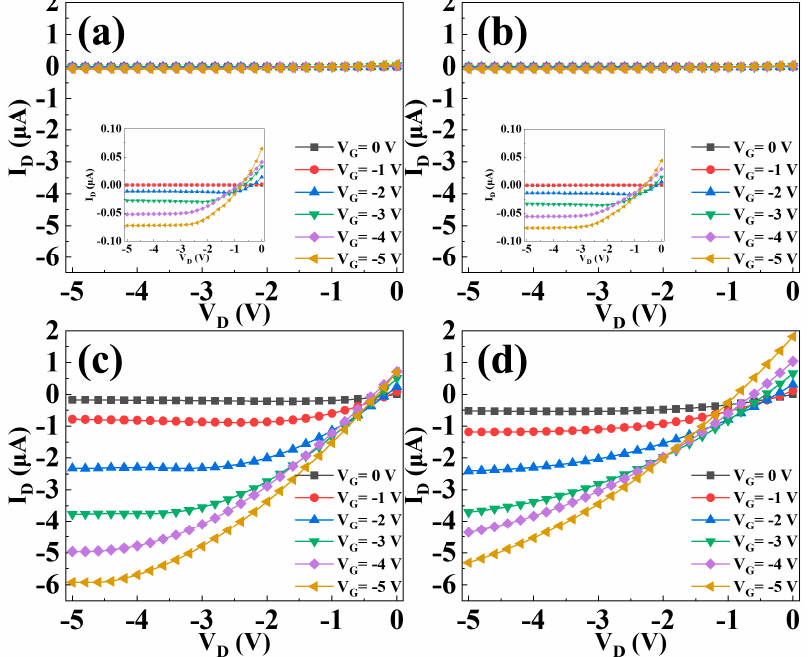
Figure 7. Output characteristics of the OTFTs with increasing Ti content in gate dielectric: ( a ) sample A, ( b ) sample B, ( c ) sample C, and ( d ) sample